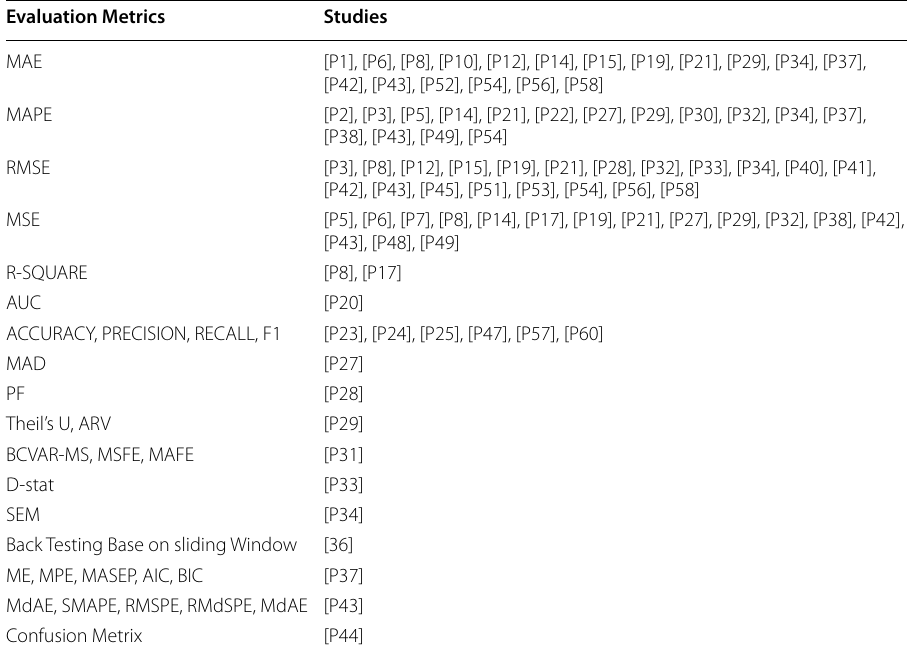
Table 8 Evaluation metrics and corresponding primary studies Evaluation